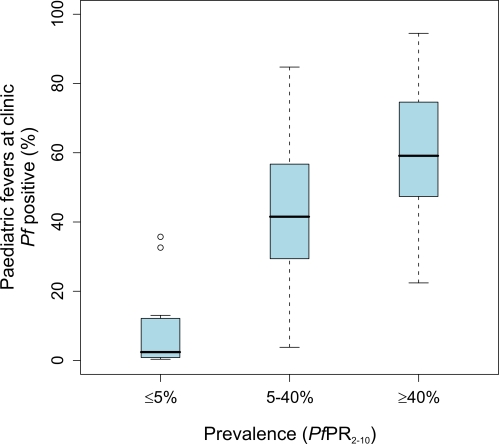
Risks of febrile children being infected when presenting to clinics within three epidemiological strata of unstable/≤5% PfPR2–10, >5% to <40% PfPR2–10, and ≥40% PfPR2–10.The box indicates the IQR (25% and 75%); the thick line within the box represents the median; the whiskers represent the 2.5% and 97.5% centiles; and outliers are plotted as circles outside this range.